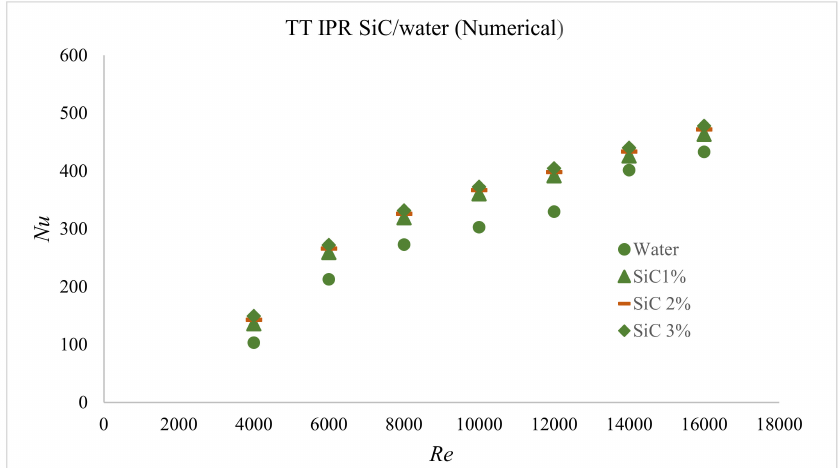
Figure 24. E ff ect of the nanofluid volume fraction ϕ on Nu